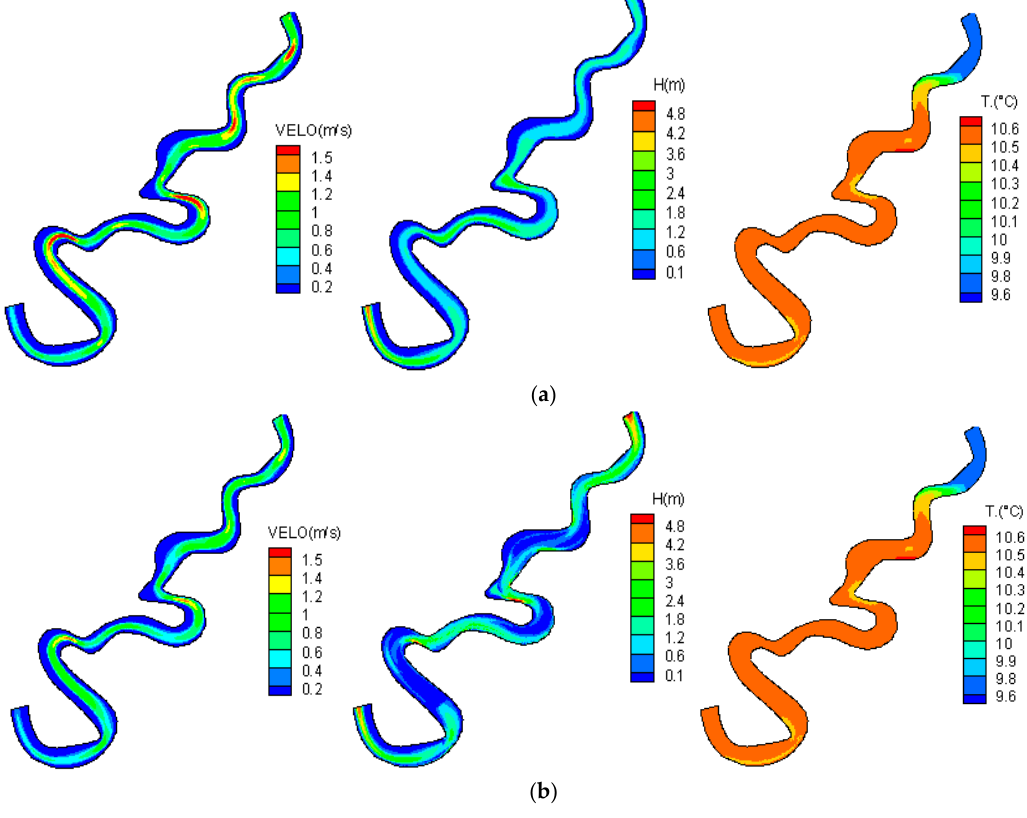
Figure 6. Simulation output of the velocity, water depth and temperature distribution before the high flow effect (HFE) ( a ) and after the HFE ( b ). (VELO = velocity; H = water depth; T. = temperature; HFE = high flow effect).